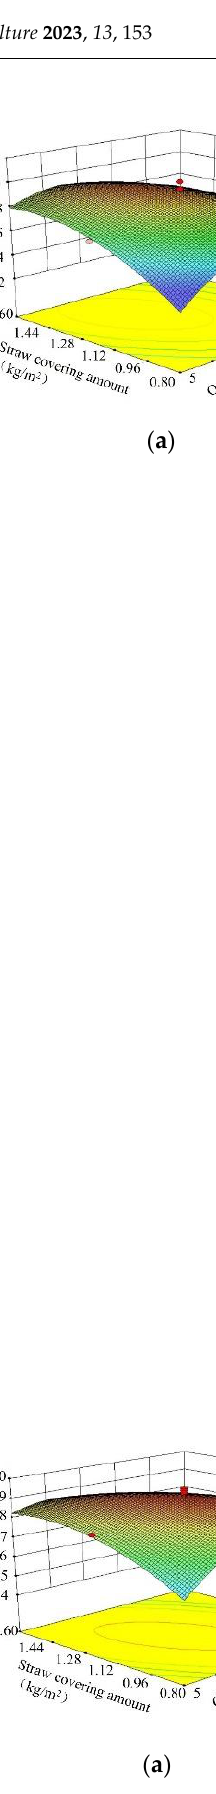
Figure 11. Influence law of various factors on qualified rate of operation depth.